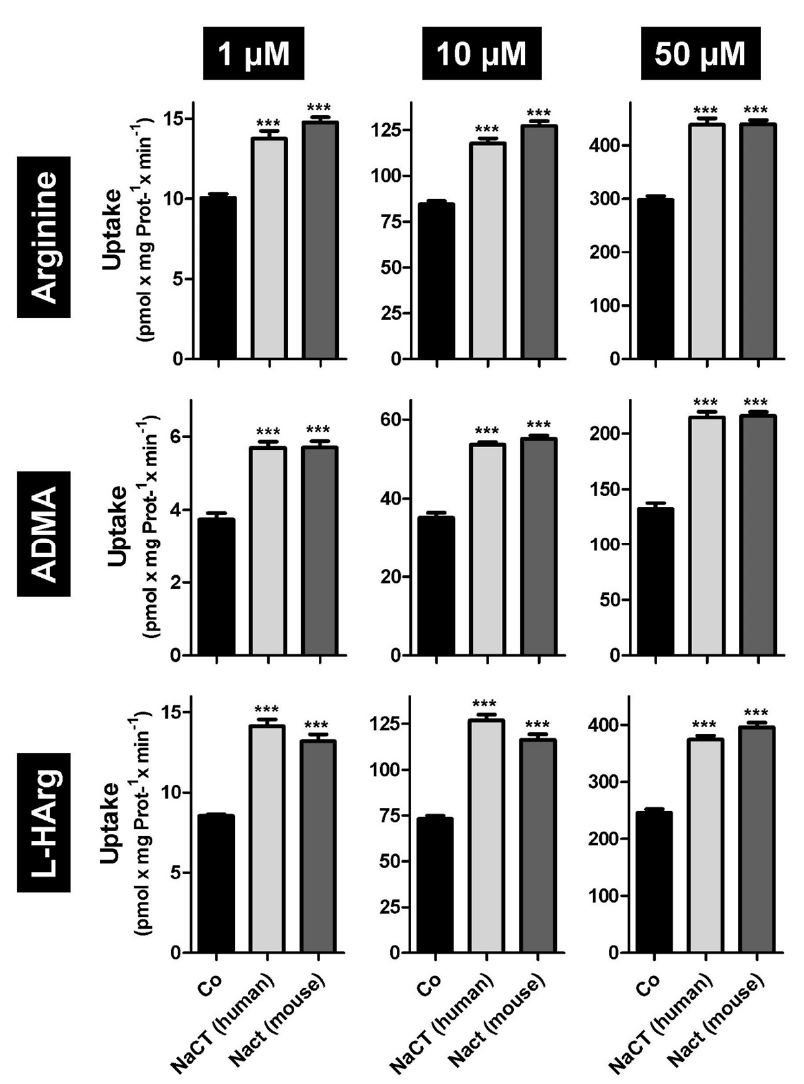
Figure 1. Initial uptake experiments with HEK-NaCT (NaCT human—light grey bars), HEK-Nact (Nact mouse—dark grey bars) and HEK-Co/418 (Co—black bars) cells using arginine, asymmetric dimethyl arginine (ADMA), and L-homoarginine (L-HArg) as substrate. All substances were added in three different concentrations (1 µM, 10 µM and 50 µM) *** p < 0.001 vs uptake in Co.